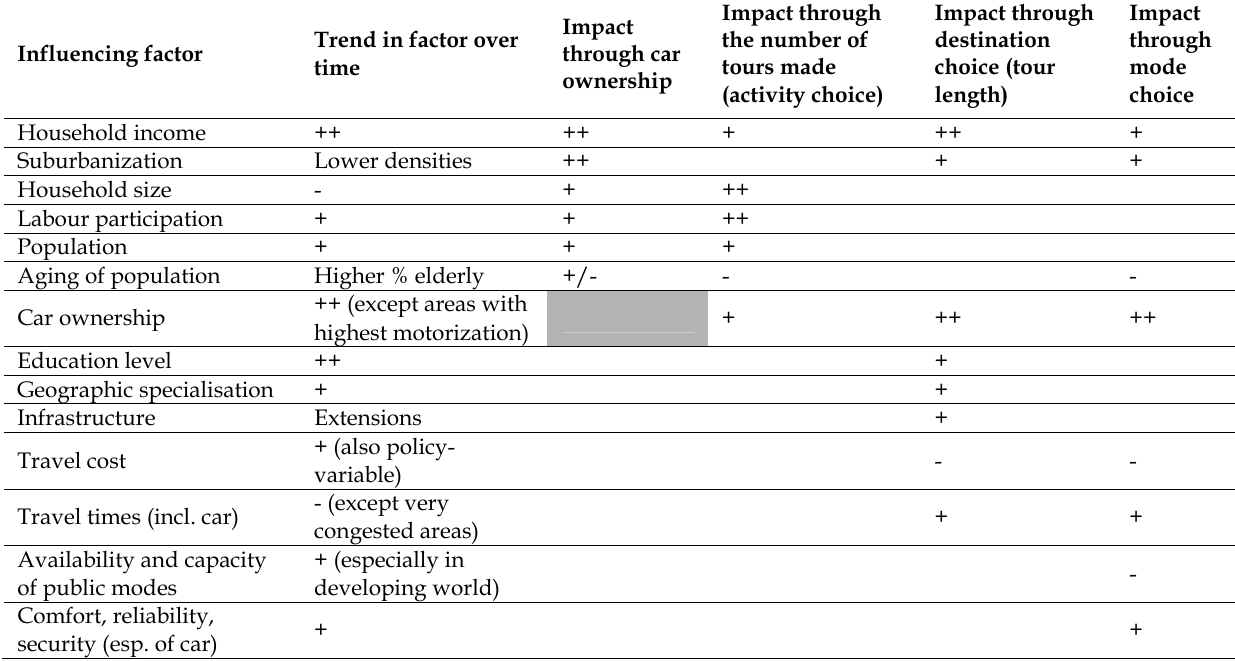
Table 5. Relative importance of drivers of the future number of passenger kilometres by car